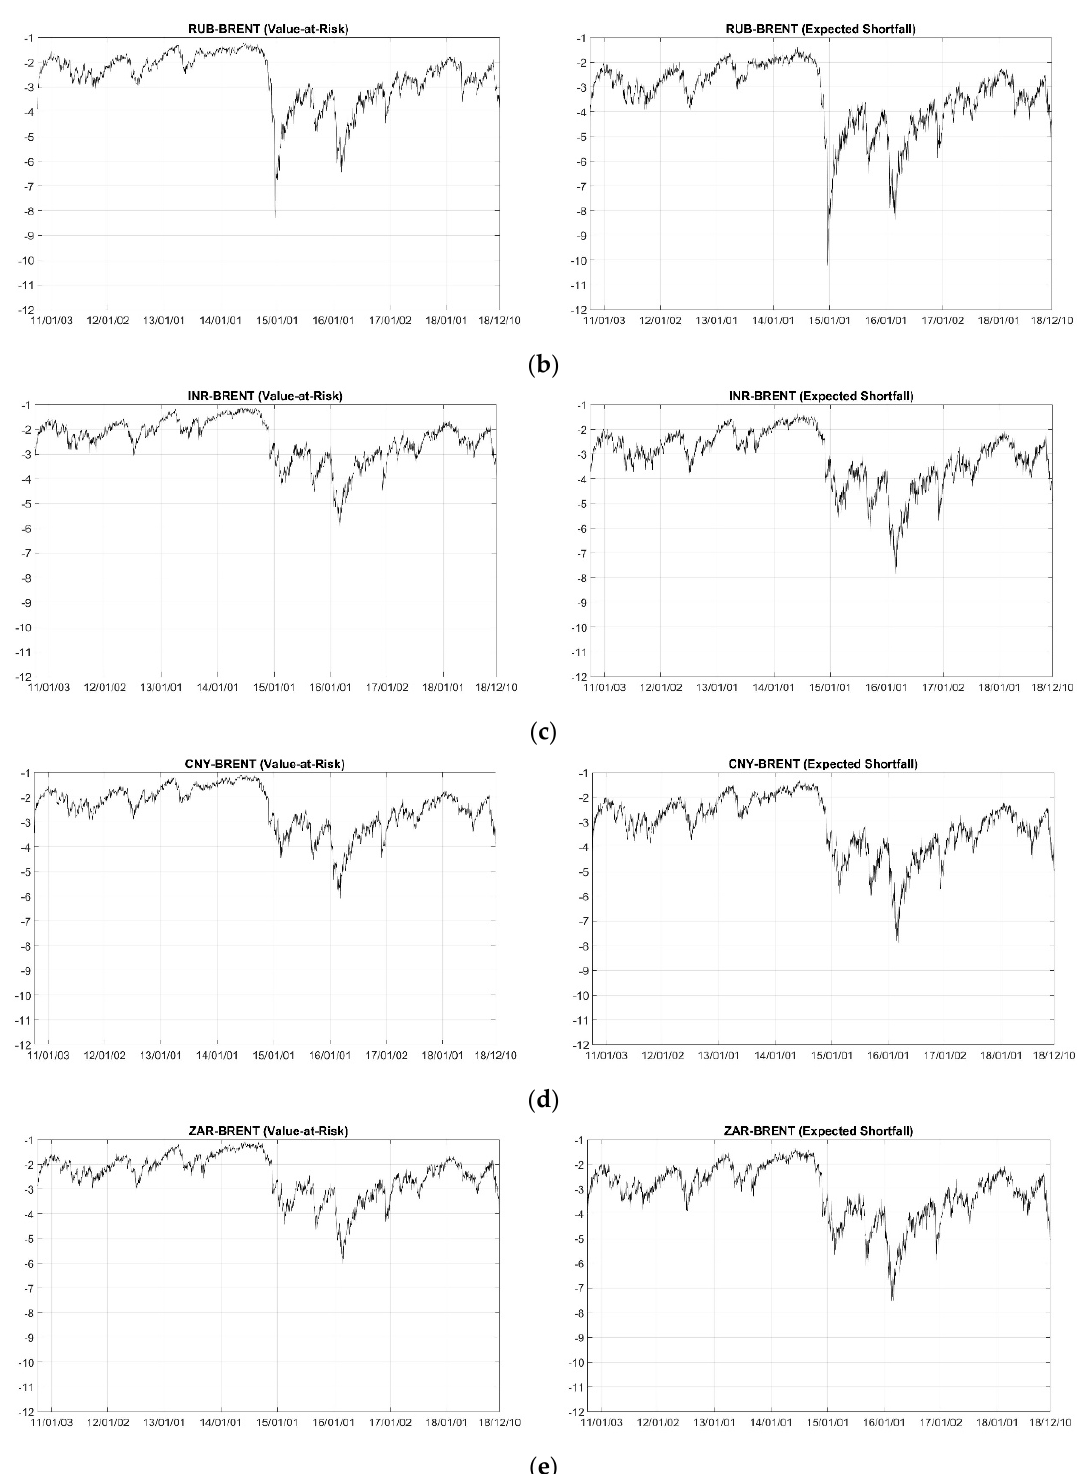
Figure A3. Conditional 1% Value-at-Risk (left panel) and Expected Shortfall (right panel) for an equal-weighted portfolio based on the Student’s t copula model. (a)-(e) refer to pair of BRL–BRENT, RUB–BRENT, INR–BRENT, CNY–BRENT and ZAR–BRENT pairs, respectively.